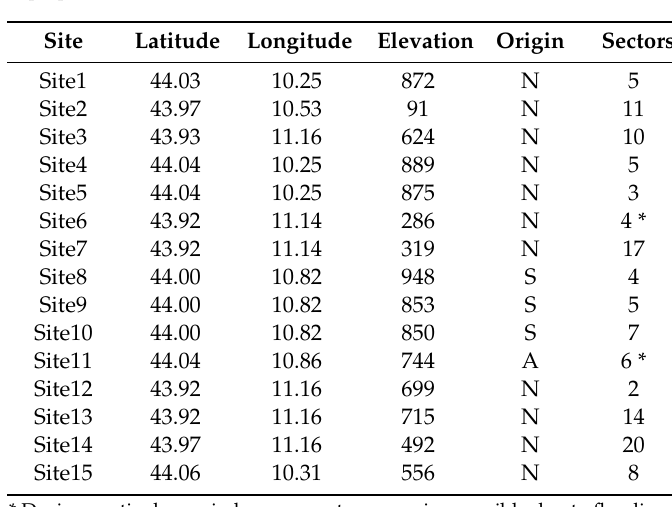
* During particular periods, some sectors were inaccessible due to